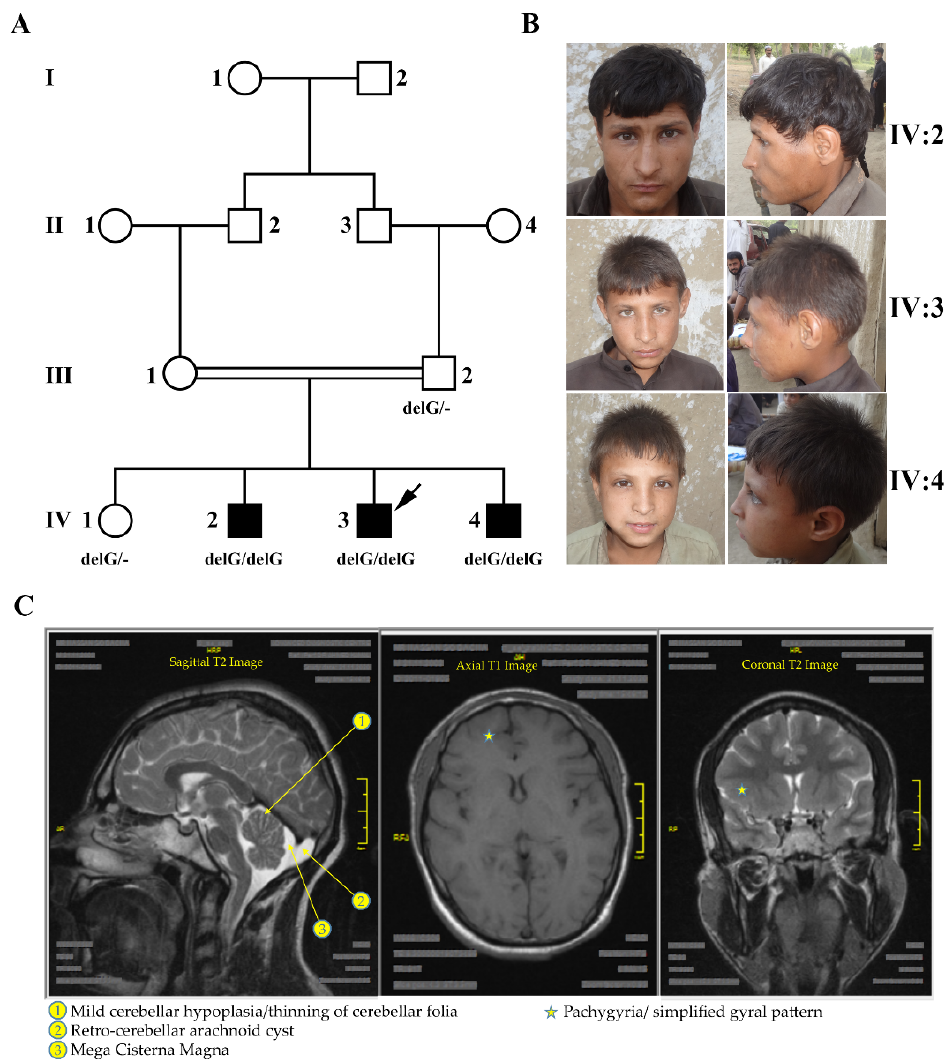
Figure 1. Ascertainment of a Pakistani family with primary microcephaly. ( A ) Pedigree of a consan- guineous family afflicted with autosomal recessive primary microcephaly, recruited from Northern Pakistan. The arrow points to the person whose DNA was subjected to WES. Genotypes for AKNA variant c.2737delG are indicated below the symbols of the tested family members. ( B ) Photographs of the three affected siblings in the fourth generation who exhibit microcephaly along with intellectual disability and mild speech/hearing deficit. ( C ) MRI images of the brain of individual IV-3. In addition to the reduced cerebral cortex, mild cerebellar abnormalities, pachygyria and a frontal simplified gyral pattern are